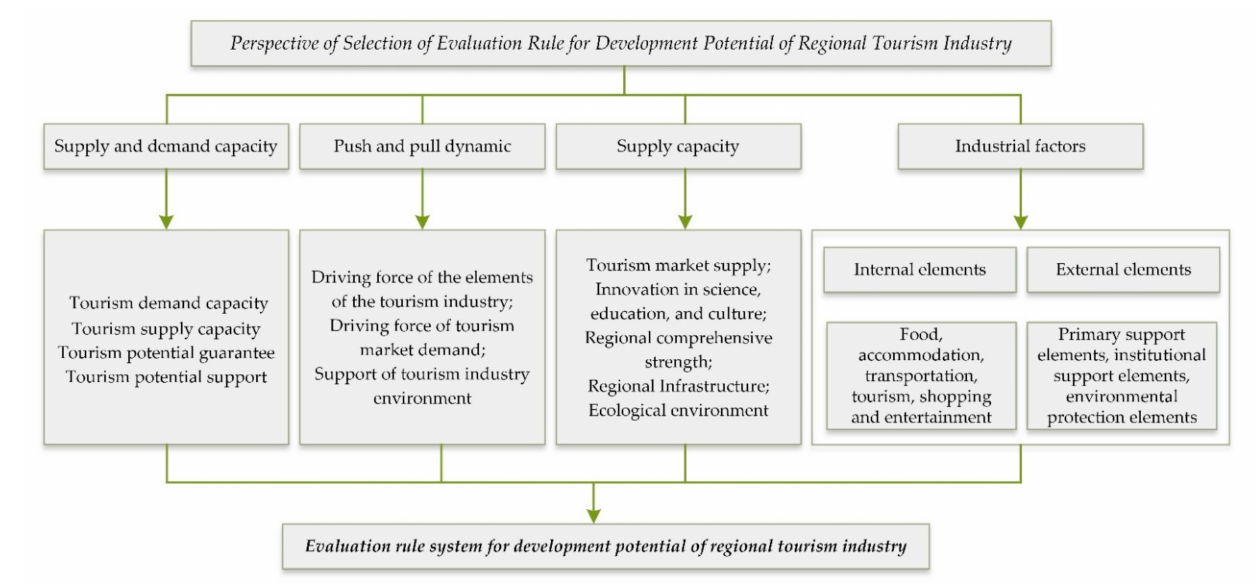
Figure 2. Evaluation rules for the development potential of regional tourism